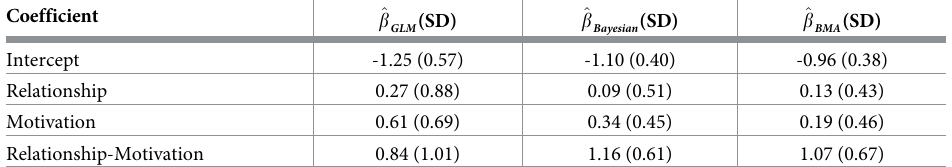
Table 11. Comparison of coefficients and standard errors from standard GLM, Bayesian GLM posterior estimates (using vague priors) and GLM posterior estimates via